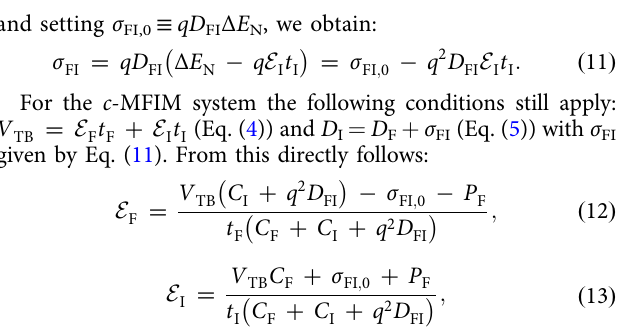
Fig. 1 Free-charge-conducting metal-ferroelectric-insulator-metal ( c -MFIM) system with surface charge density σ FI at the ferroelectric-insulator (FERRO-INS) interface. a Schematic of the MFIM structure with indicated location of σ FI . The FERRO layer, with length L and thickness t F = 3.5 nm, is characterized by a spontaneous polarization density P F and electric fi eld strength E F . Similarly, the INS layer, with thickness t I = 1 nm, is characterized by an electric fi eld strength E I and electric permittivity ε I = 3.9. b Time signal of the applied input voltage V TB with peak magnitude V p . c Energy band diagram ( V TB = 1 V) showing the Fermi energy level E f at the top ( E f (0)) and bottom ( E f ( t Σ = t F + t I )) metal contact, and the interface charge-neutrality level E N . The interface state density D FI is assumed to be constant across the entire FERRO-INS interface. When the Fermi energy at the FERRO-INS interface is located above (below) E N , σ FI is negative